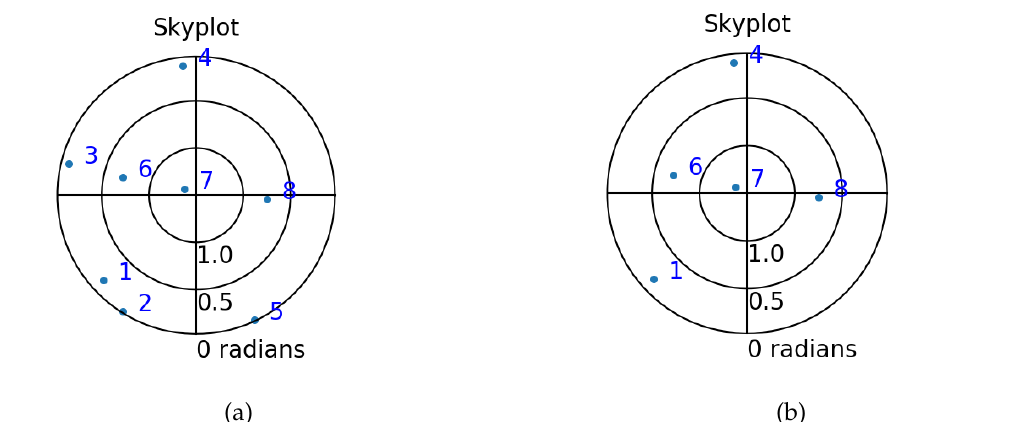
Figure 9. Skyplot with azimuth and elevation of 8 ( a ) and 5 ( b ) satellites for the analysis of SF-PPP GNSS